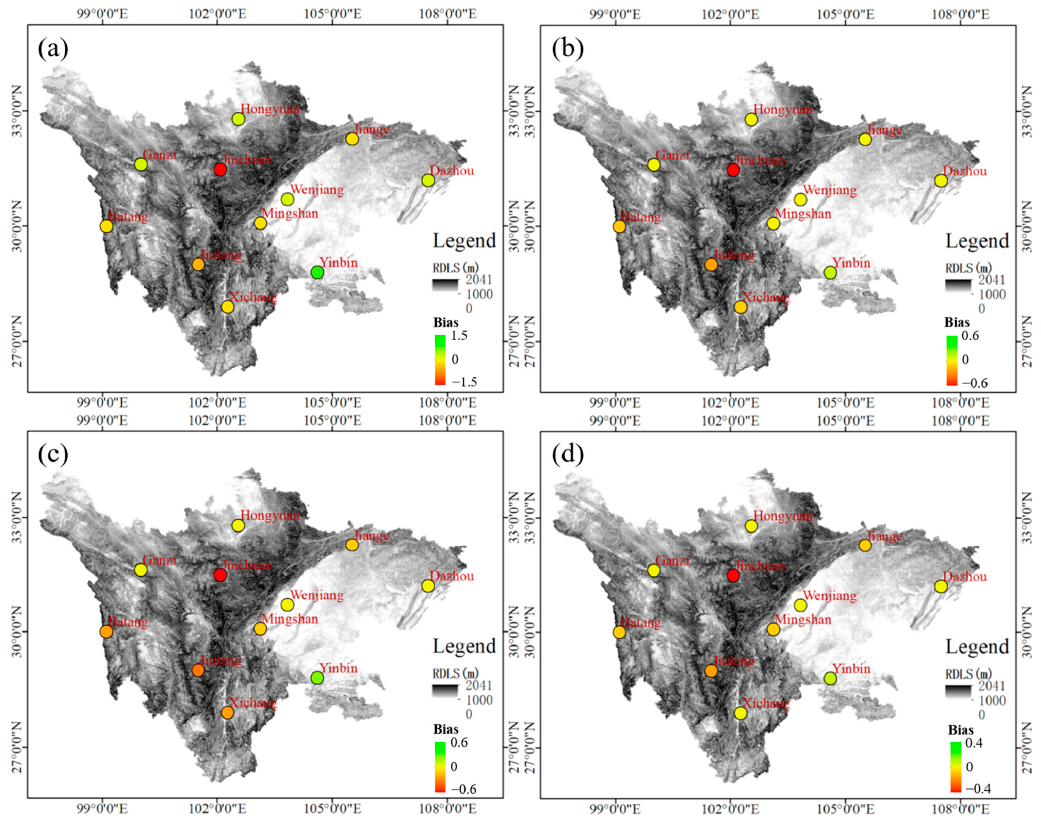
Figure 9. Spatial distribution of Bias and RDLS. ( a ) Whole layer; ( b ) high layer; ( c ) middle layer; ( d ) low layer.